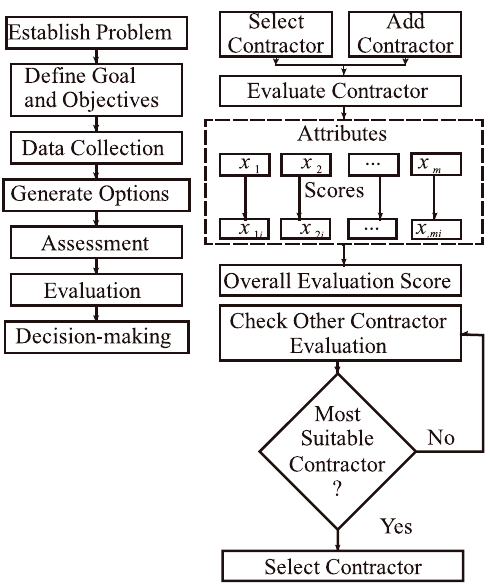
Fig. 1 . Contractor‘s evaluating and selecting